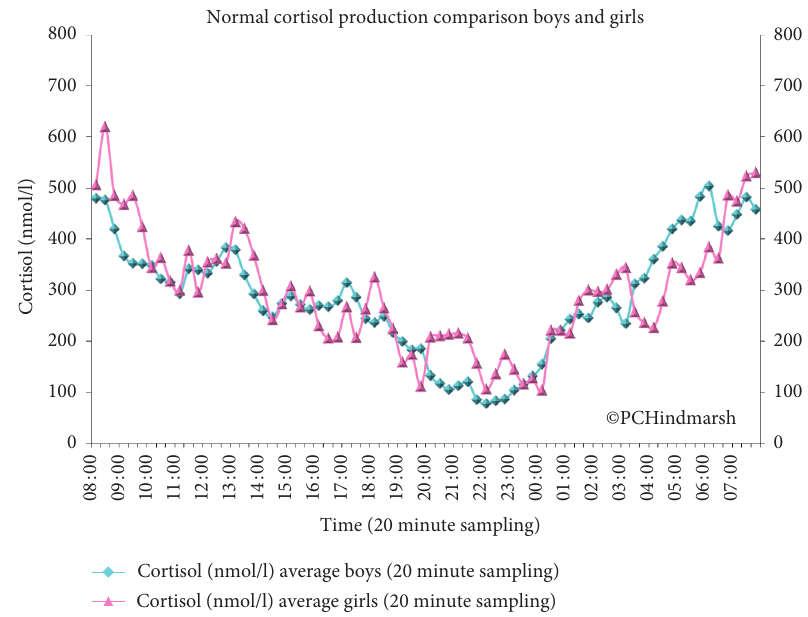
Figure 2: 24-hour plasma cortisol concentrations in 28 short prepubertal boys (blue line) and girls (pink line) with normal endocrinology. Samples are drawn at 20-minute intervals. Data are shown as mean value at each time point (see